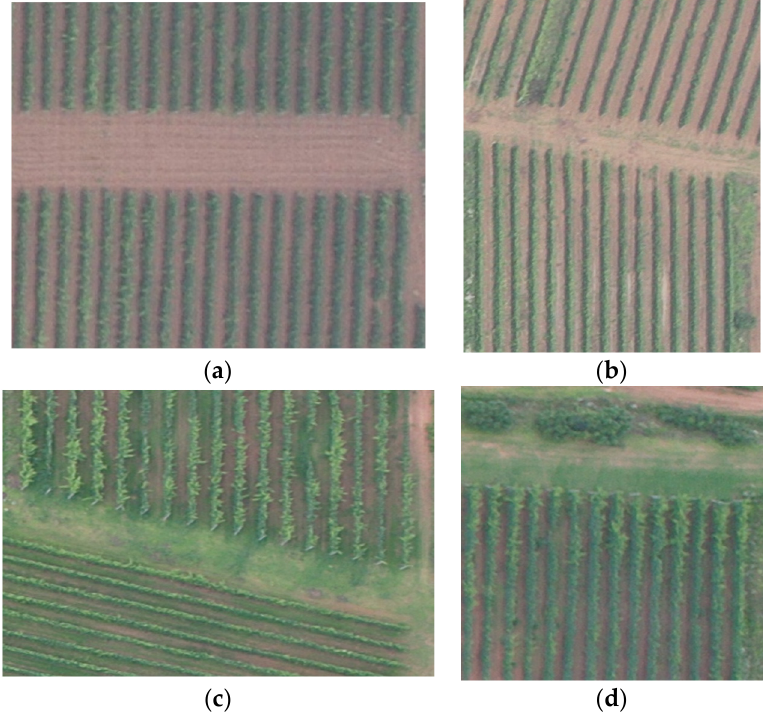
Figure 2. Four common cases of the headland space at the exit from a vineyard block. ( a ) Configuration I: the rows between adjacent blocks are parallel; ( b ) configuration II: the rows between adjacent blocks are slightly slanted; ( c ) configuration III: the rows between adjacent blocks are almost perpendicular; and ( d ) configuration IV: there is no adjacent block.